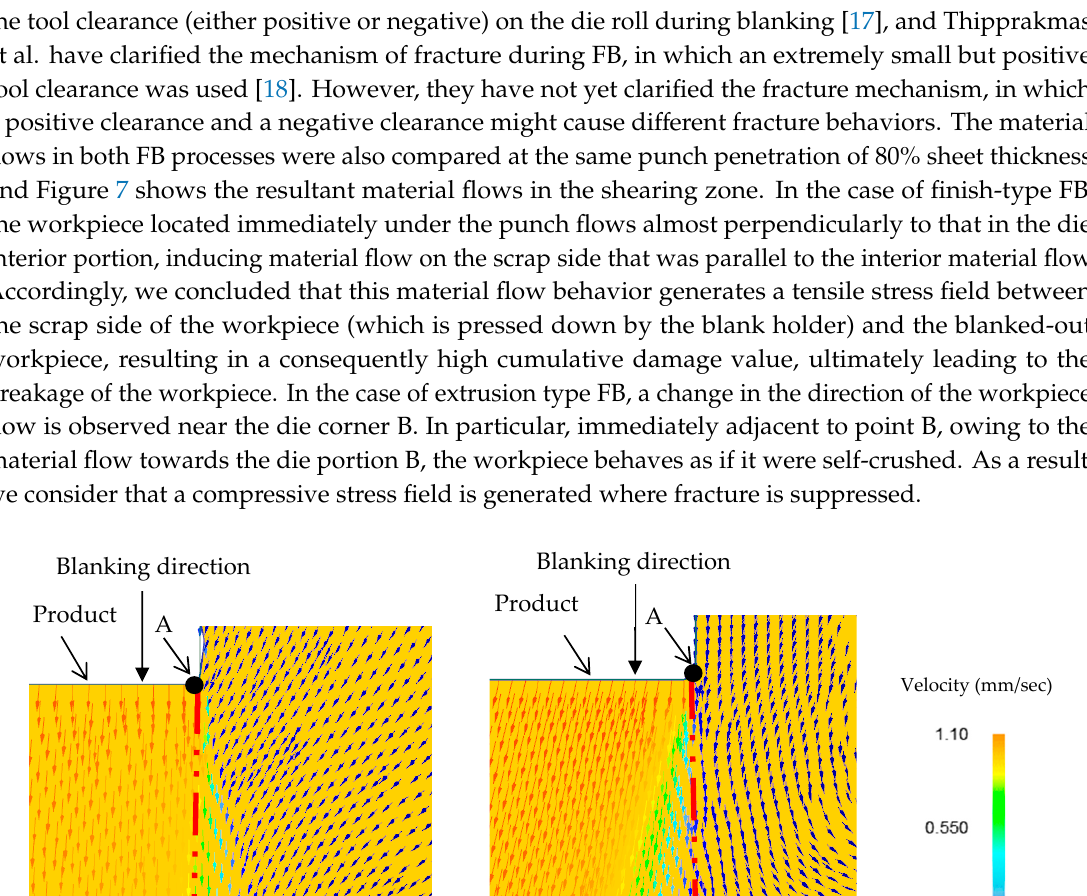
Figure 6. Comparison of maximum principal stress for 80% t punch penetration between the finish-type FB and extrusion-type FB in Figure 4: ( a ) finish-type FB; ( b ) extrusion-type FB.